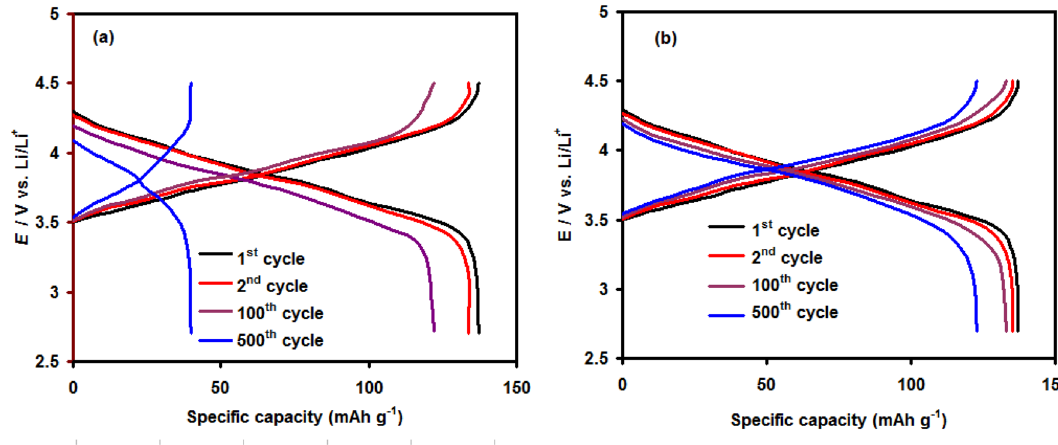
Figure 7. Charge and discharge curves of LIB (at 2C) with pristine Al foil ( a ) and coated Al foil (PANI@0.6Ni-Pc composite) ( b ) at various